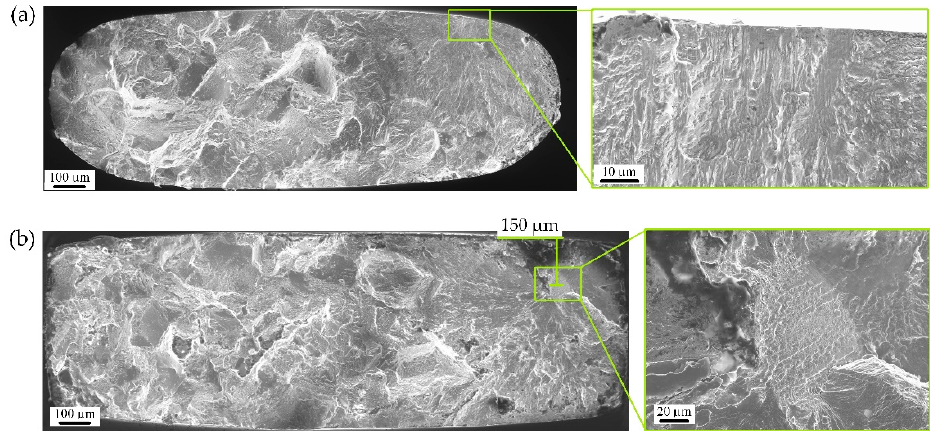
Figure 8. SEM images of intergranular crack initiation with just one isolated and pronounced slip line at a PAGB in an ( a ) NSP sample, loaded at ∆σ /2 = 680 MPa after 155,000 loading cycles, and an ( b ) SP sample, loaded at ∆σ /2 = 730 MPa after 286,120 loading cycles.